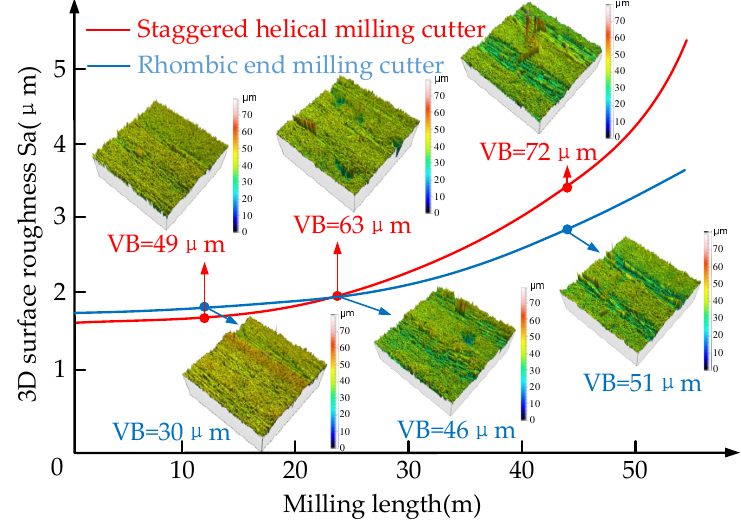
Figure 6. The surface roughness changed with the difference of milling lengths.